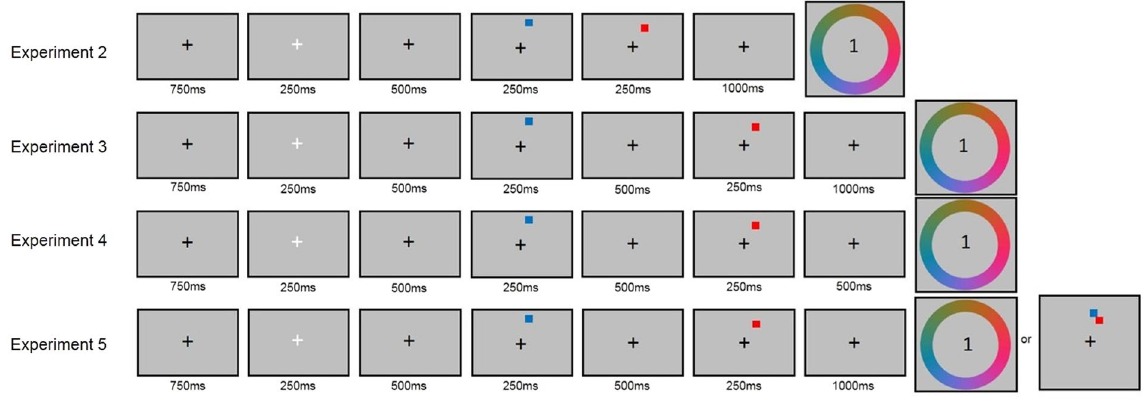
Figure 5. The trial sequence for the Near conditions of Experiments 2–5.